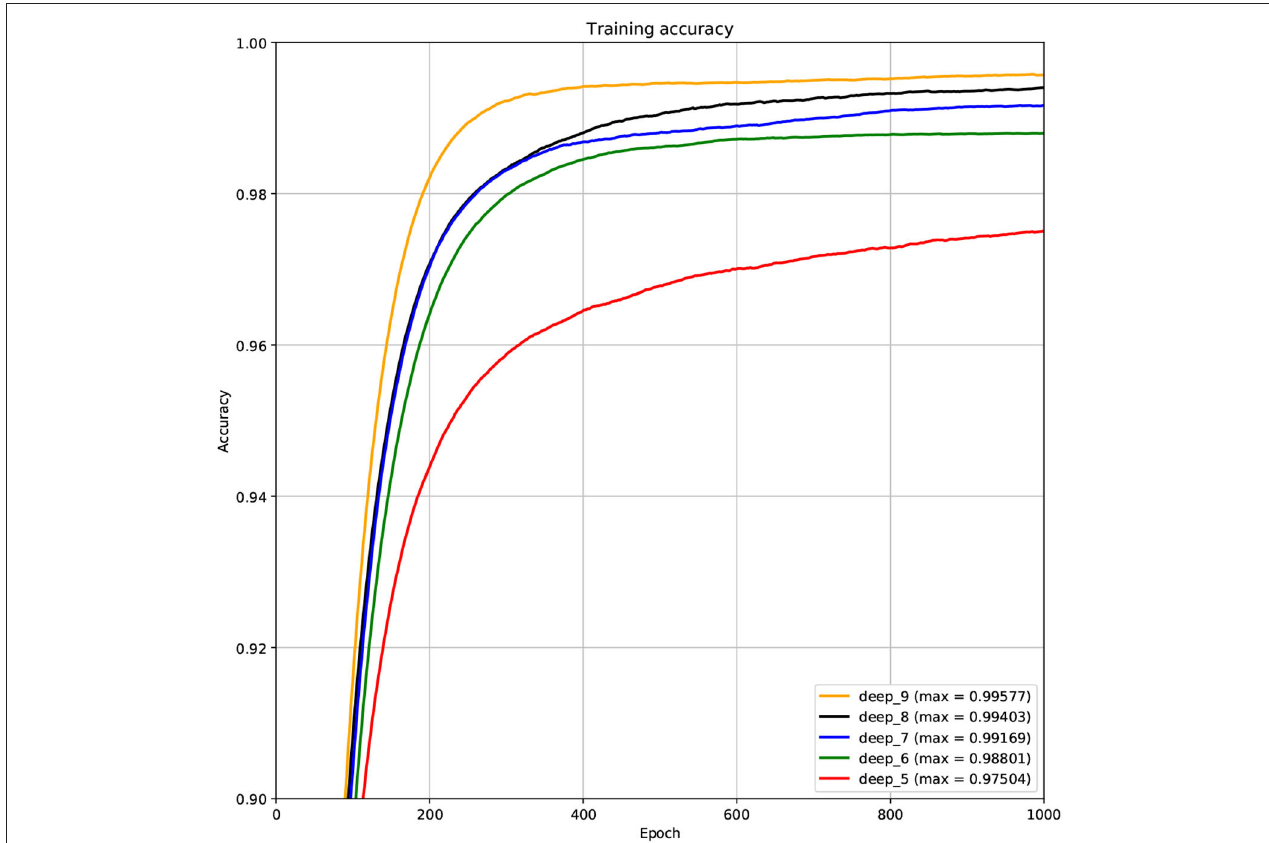
FIGURE 3 | The variation curve of the training accuracy.